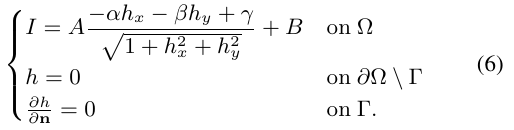
Figure 2. The output of the shape-from-shading is robust to changes to the mean of f . The mean normalised image is shown in (a) and the resulting surface in (b). In (c) and (d) we modified this mean to observe that it results in a slight slope on the reconstructed surface. Although some differences can be observed along the boundaries of the bands the stockpiles are barely